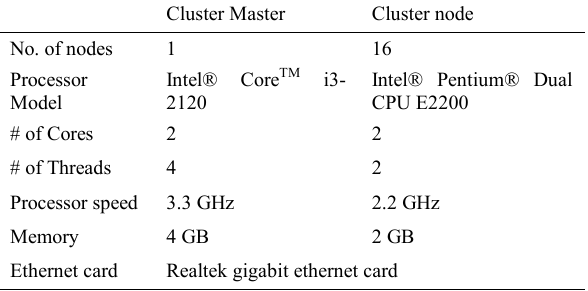
Table 1. Summary of the diskless-based PC cluster